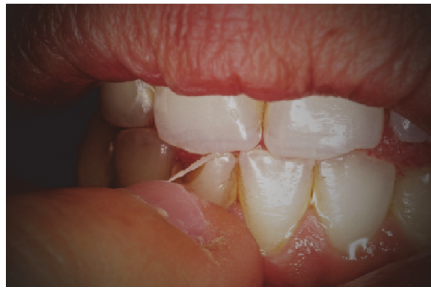
Figure 2: A V-shaped notching of the incisal edges of both right maxillary central and lateral incisors is associated with occlusal position of nail biting (scroll-up).